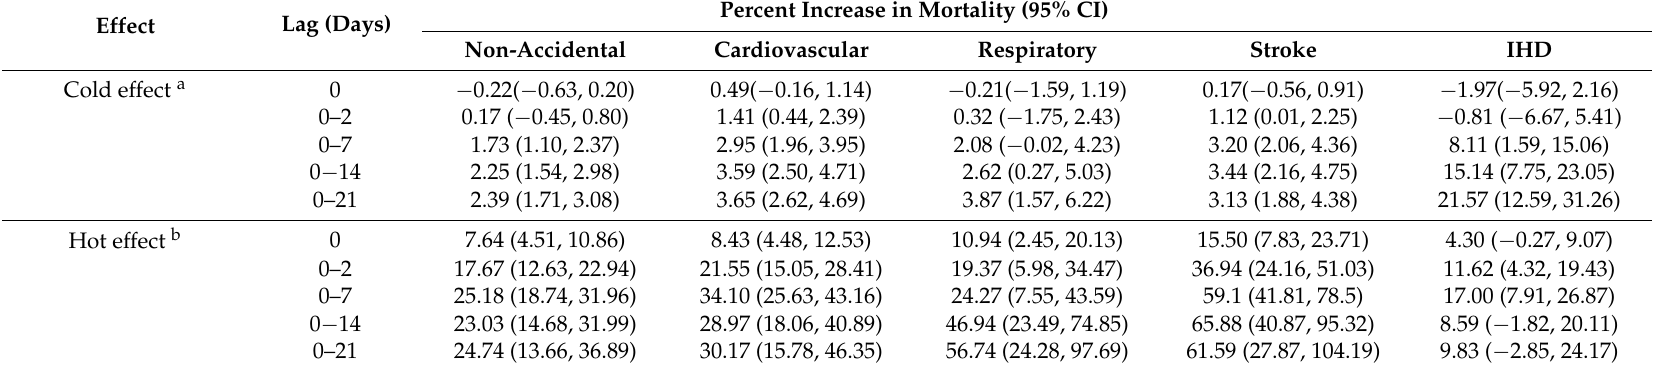
Table 5. The cumulative cold and hot effects of mean temperature on cause-specific mortality along the lag days, using a double-threshold-natural cubic spline DLNM with 4 df natural cubic spline for